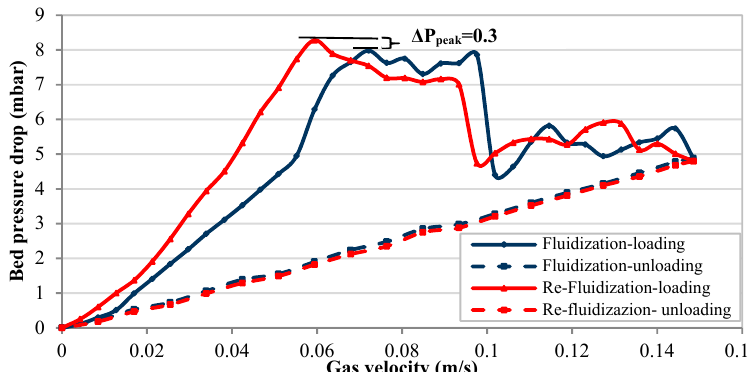
Figure 9. Fluidization and re-fluidization behaviors (after compression at 40 kPa) for a mixture of 50% of ultra-fine + 50% of fine particles.